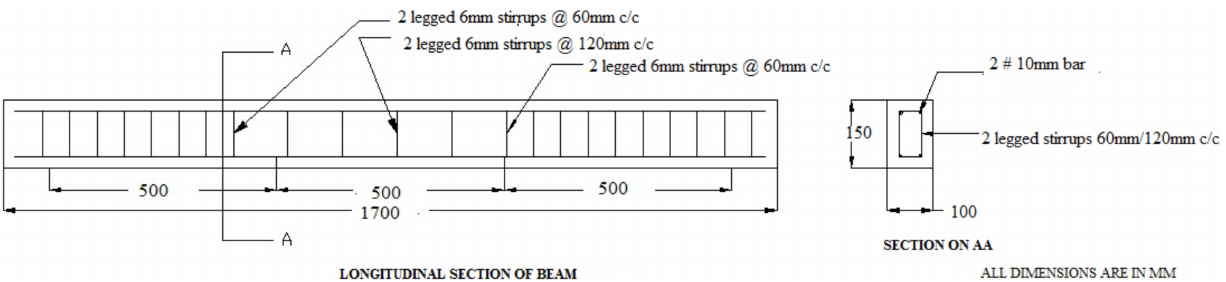
Figure 4. Reinforcement details and specimen